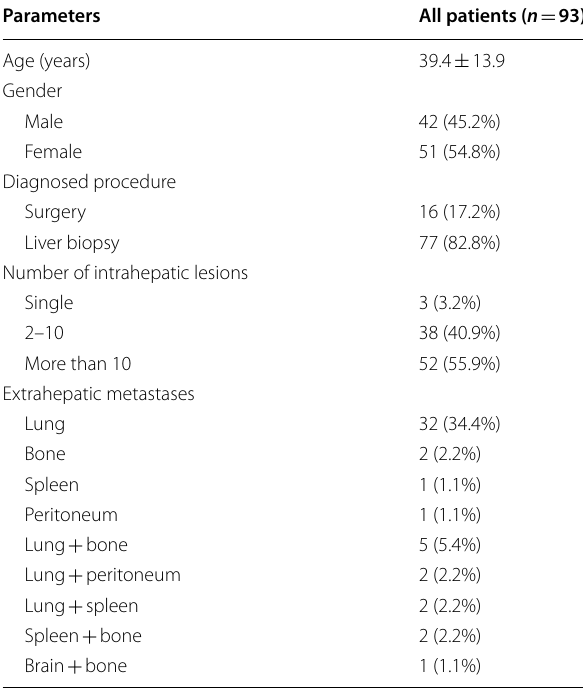
Table 1 Demographic summary of included patients